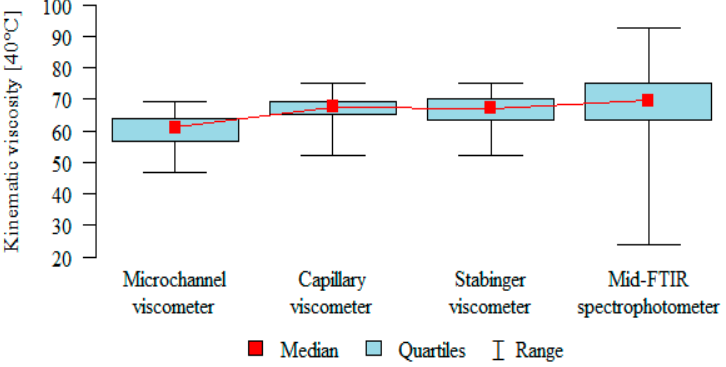
Figure 6. The box plot of the results obtained with the use of the analyzed devices. The above-made observations can be also confirmed by another type of chart (Figure 7).